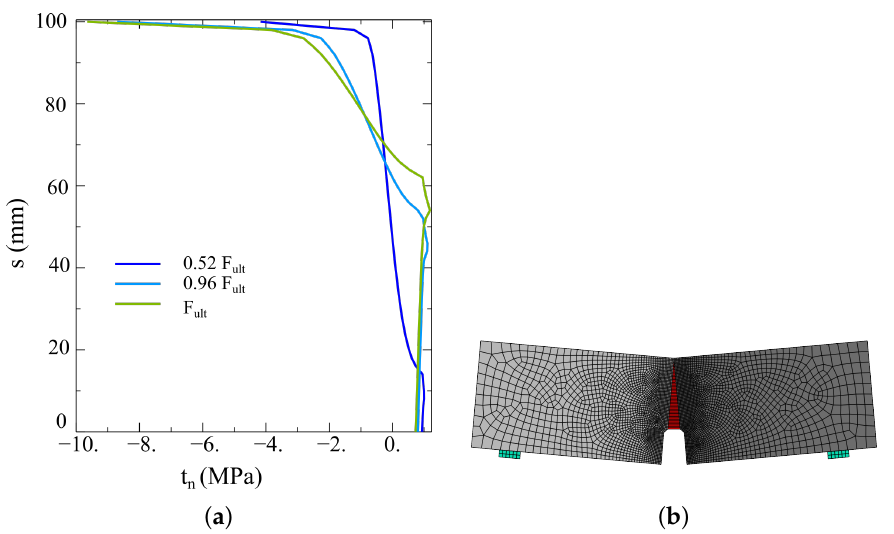
Figure 12. ( a ) Normal traction distribution along with the interface for different load levels. ( b ) De- formed model.